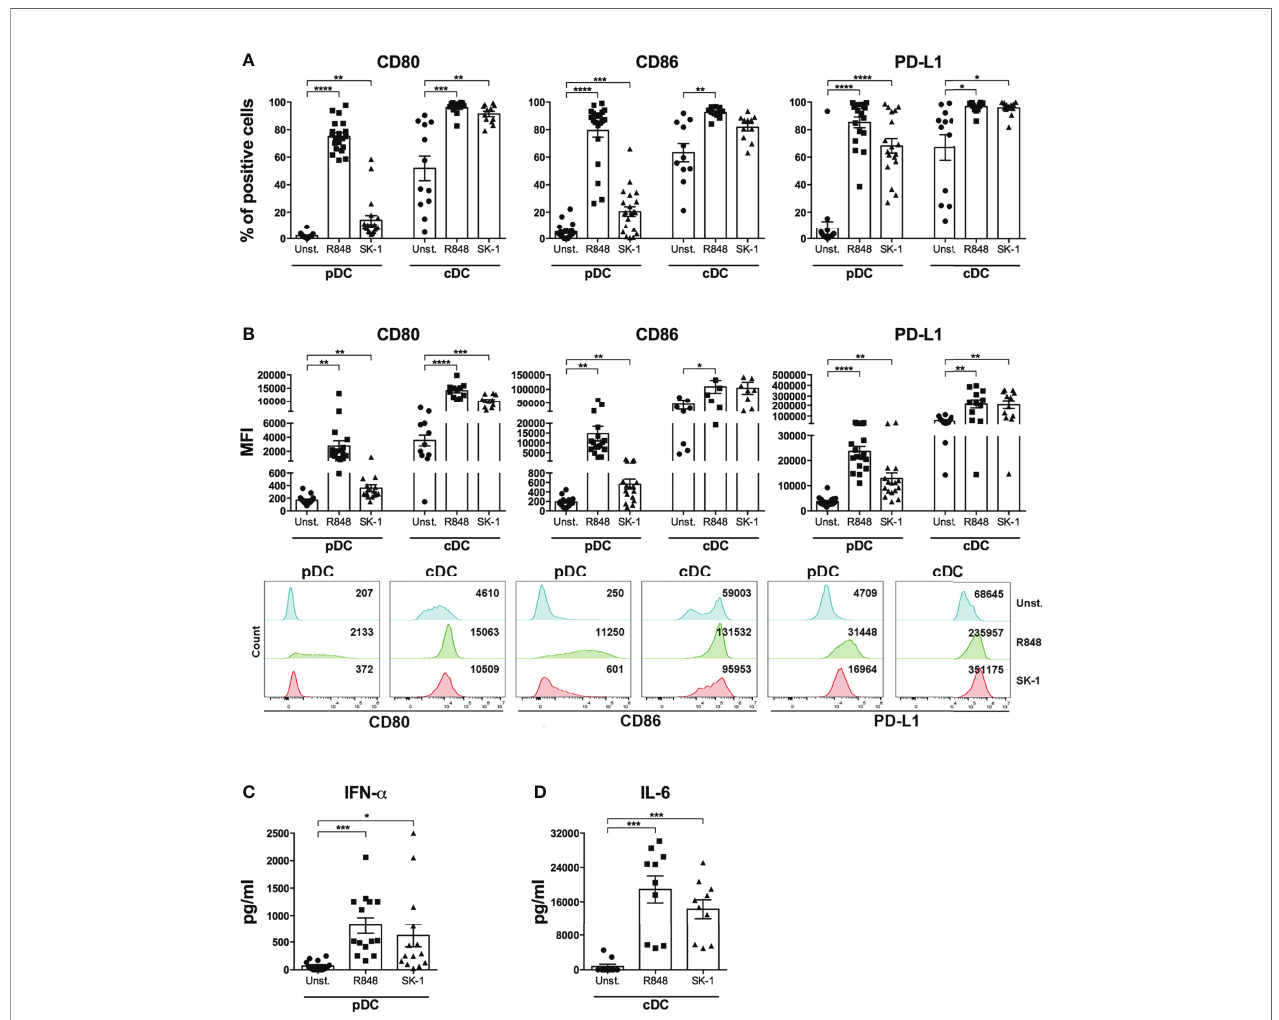
FIGURE 1 | The laboratory strain of Saccharomyces cerevisiae SK-1 promotes the activation of human blood dendritic cells. Human pDCs and cDCs puri fi ed from the peripheral blood of healthy donors were cultured for 48 h without stimulation (Unst.), with R848 (1 m g/ml) as positive control, or with the laboratory strain of Saccharomyces cerevisiae SK-1 at multiplicity of infection = 5 (colony-forming unit SK-1/DC). The expression of molecules CD80, CD86, and PD-L1 was analyzed by fl ow cytometry, and the percentage of positive cells (A) and median fl uorescence intensity (B) were reported. The levels of IFN- a (C) and IL-6 (D) were measured in the culture supernatants by ELISA. Data are the mean of 11 independent experiments, each from different donors. Error bars represent SEM. One-way ANOVA was used to compare the different experimental conditions (*= p -value ≤ 0.05; **= p -value ≤ 0.01; ***= p -value ≤ 0.001; ****= p -value ≤